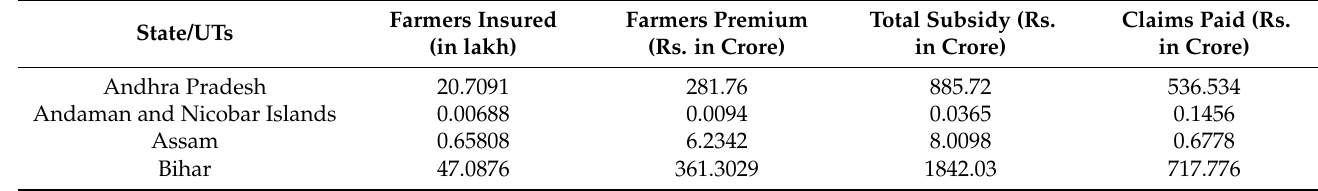
Table A5. State-wise performance of PMFBY—cumulative up to